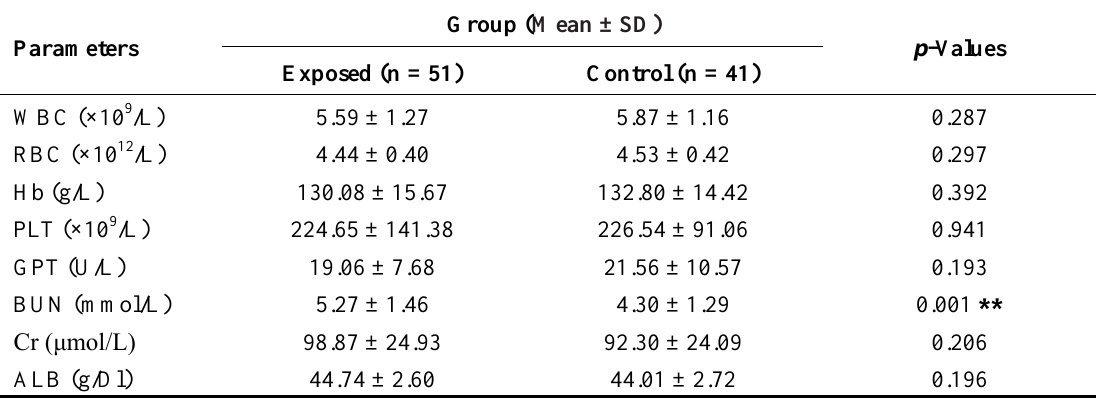
Table 5. Mean values of serum chemistry and hematology parameters of workers from the exposed group and control group (mean ± SD).